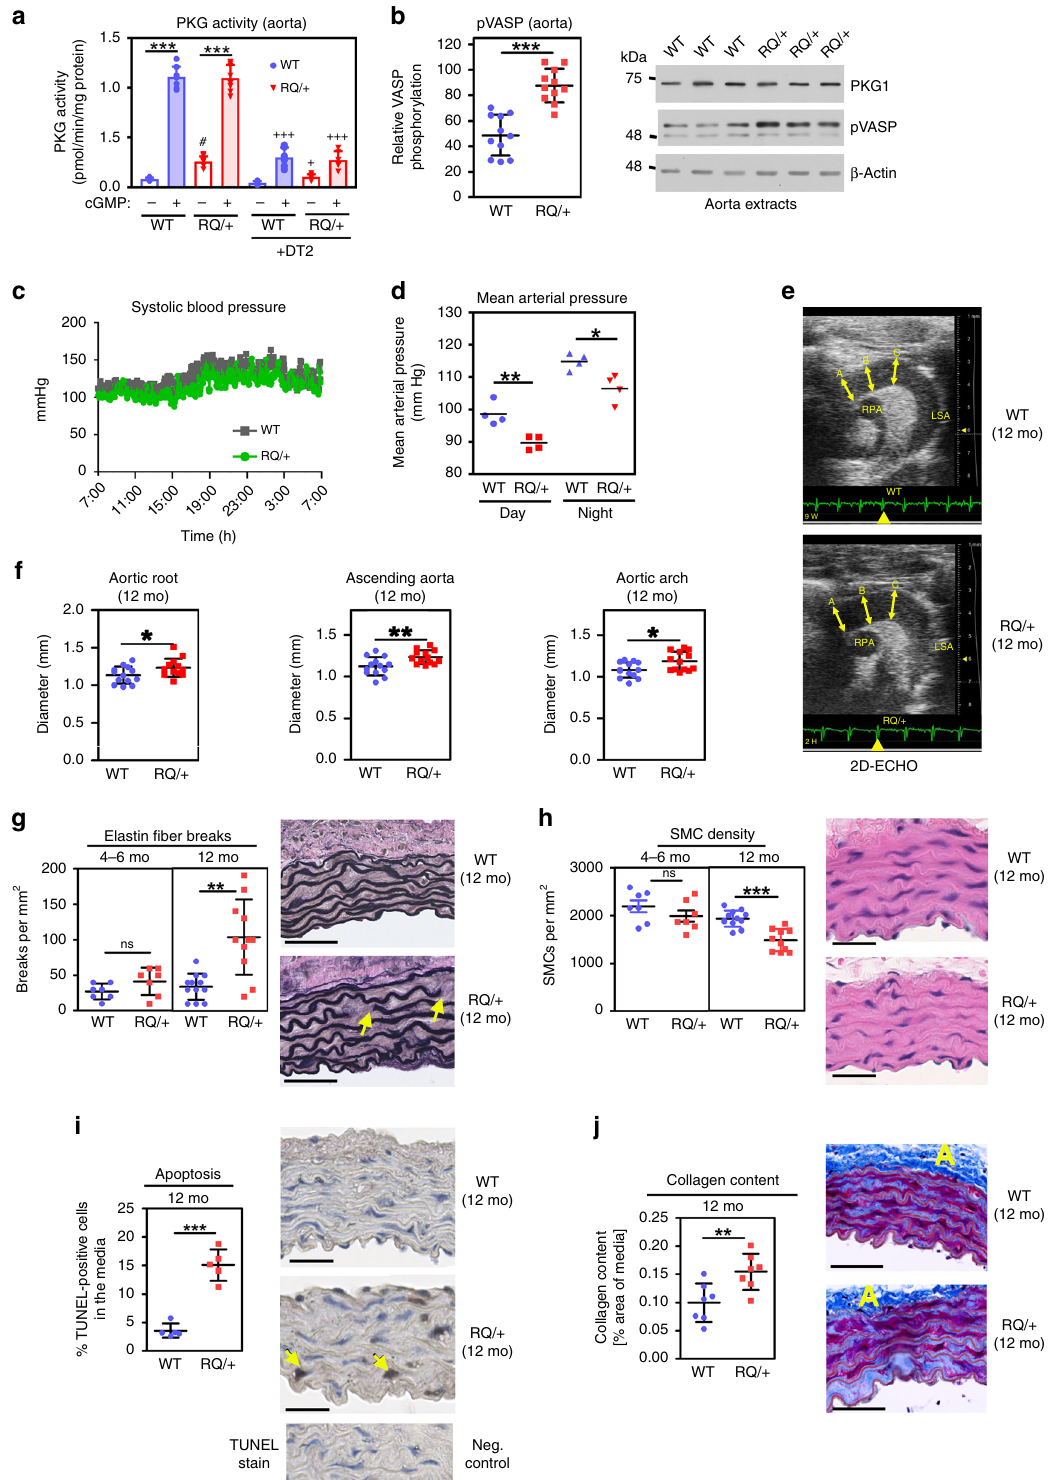
JNK upregulates MMPs and induces SMC apoptosis, and JNK inhibitors reduce aortic aneurysms in Marfan mice and in other mouse models of TAAD 7,30 – 32 . We found increased activity of both JNK and MMPs in Prkg1 RQ/ + compared to WT aortas (Fig. 2h – j), consistent with JNK activation by H 2 O 2 and via MEKK1 activation by PKG1 (refs. 30,32 – 34